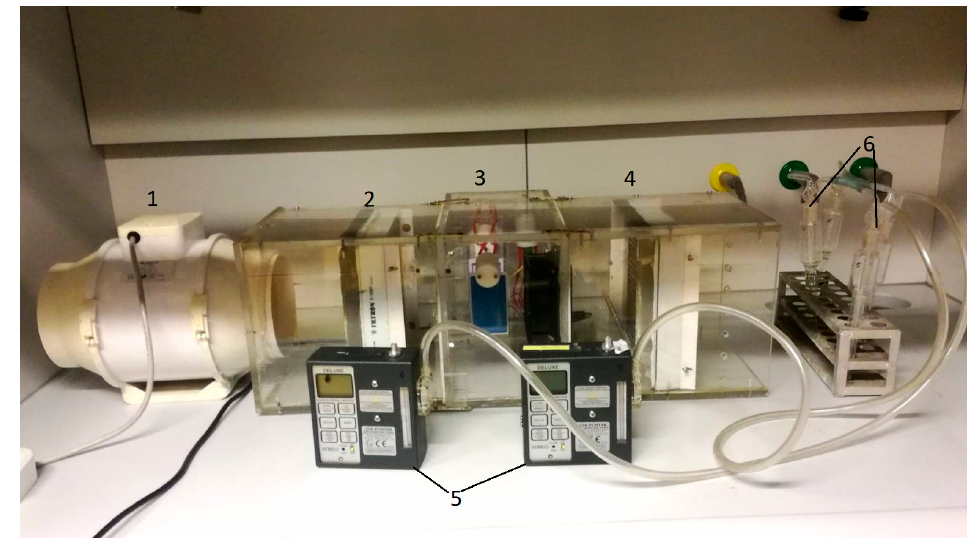
Figure 1. Construction of air purifier used in the study.